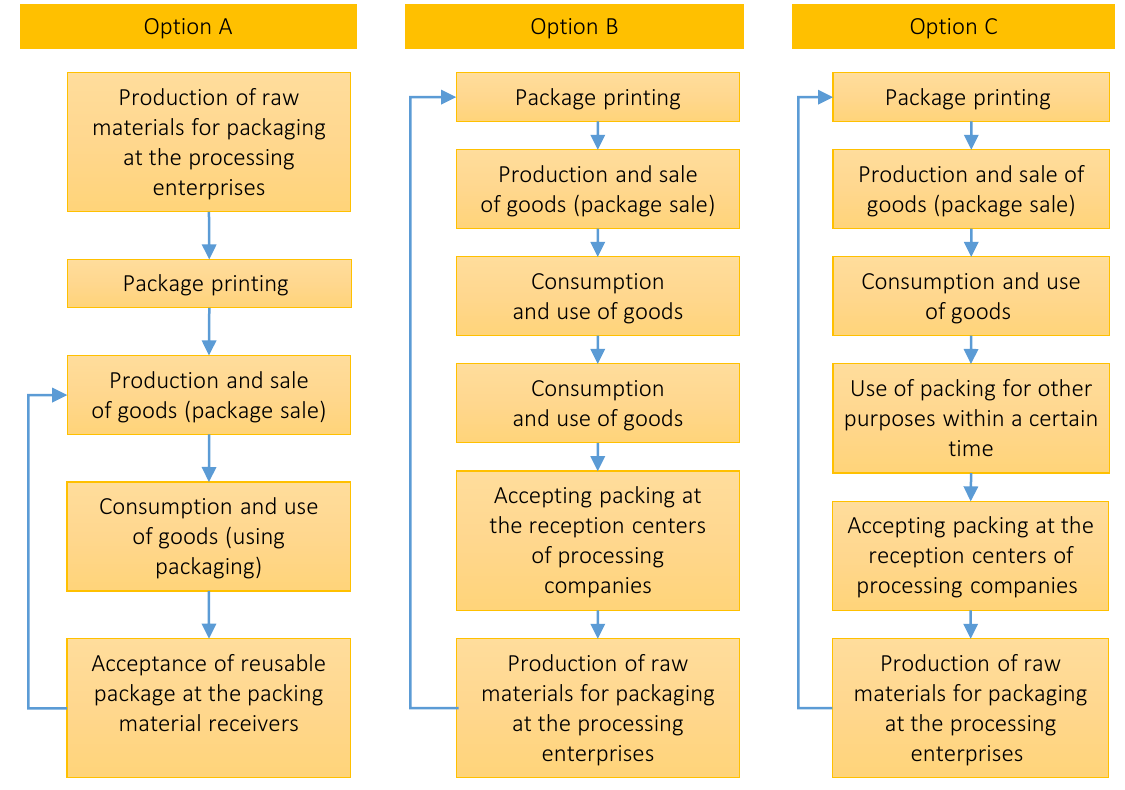
Figure 5. Recycling options for